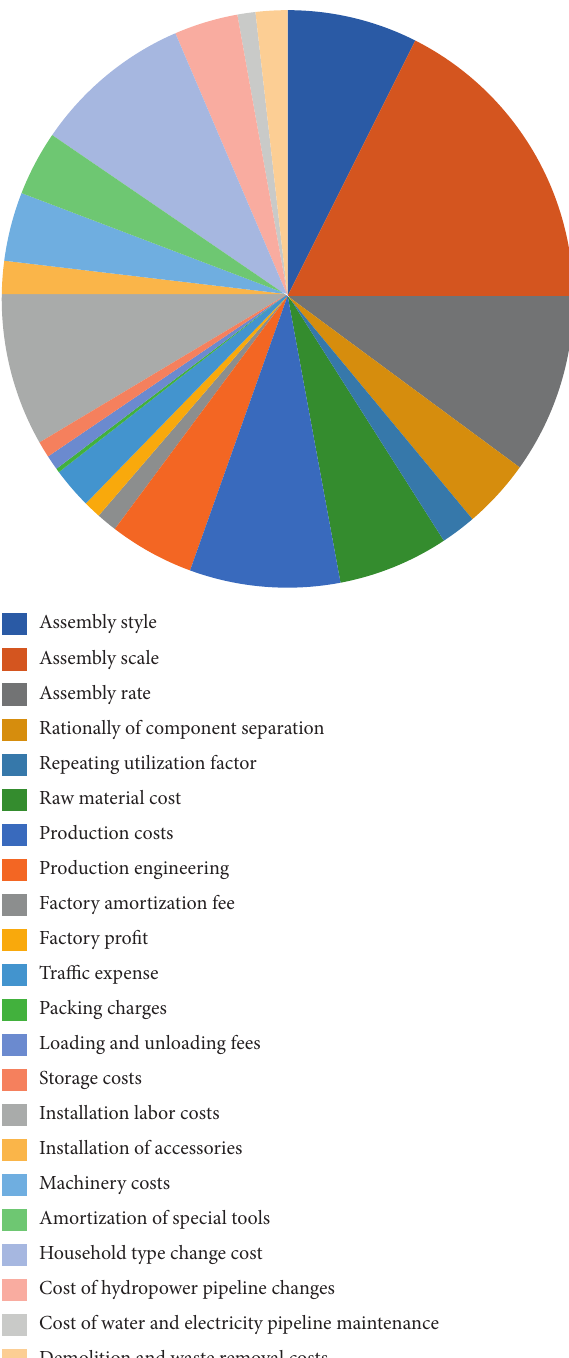
Figure 2: Global weights of Level